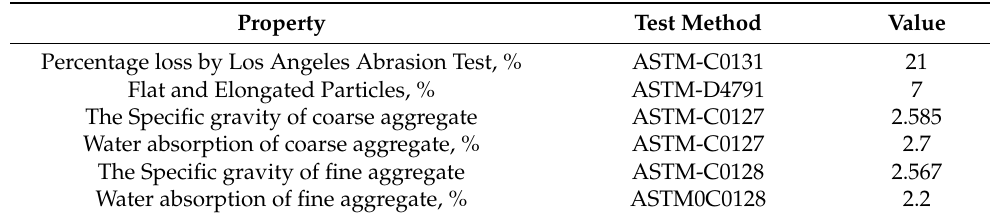
Table 3. The limestone aggregate properties.